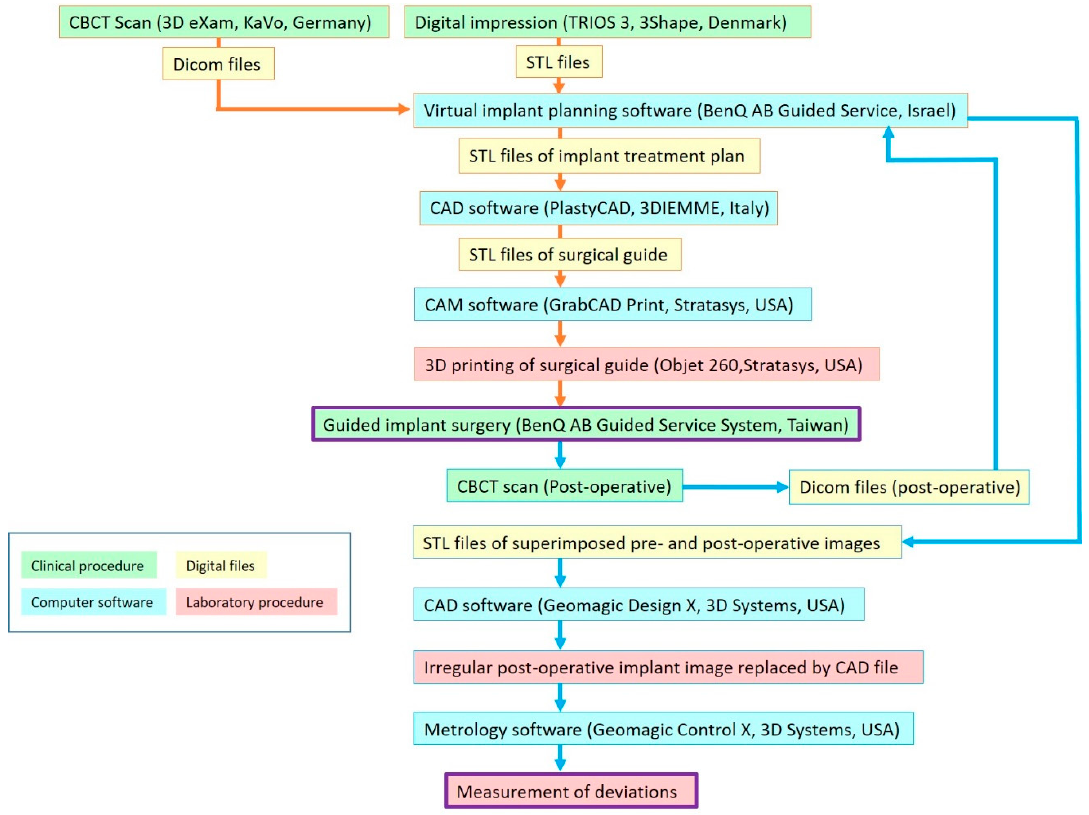
Figure 7. Summarized workflow of guided surgery (orange arrows) and deviation measurement (blue arrows).